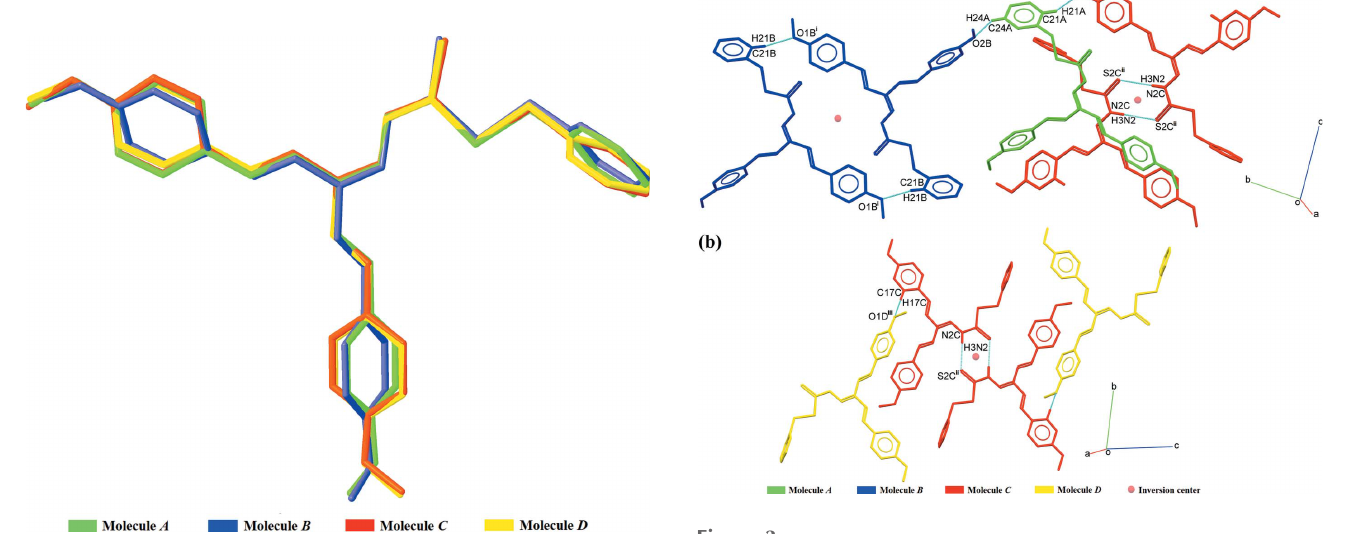
Figure 2 Overlay of the four molecules in ( I ). The r.m.s deviation of A:B = 1.038 A˚ , A:C = 0.881 A˚ and A:D = 0.947 A˚ .